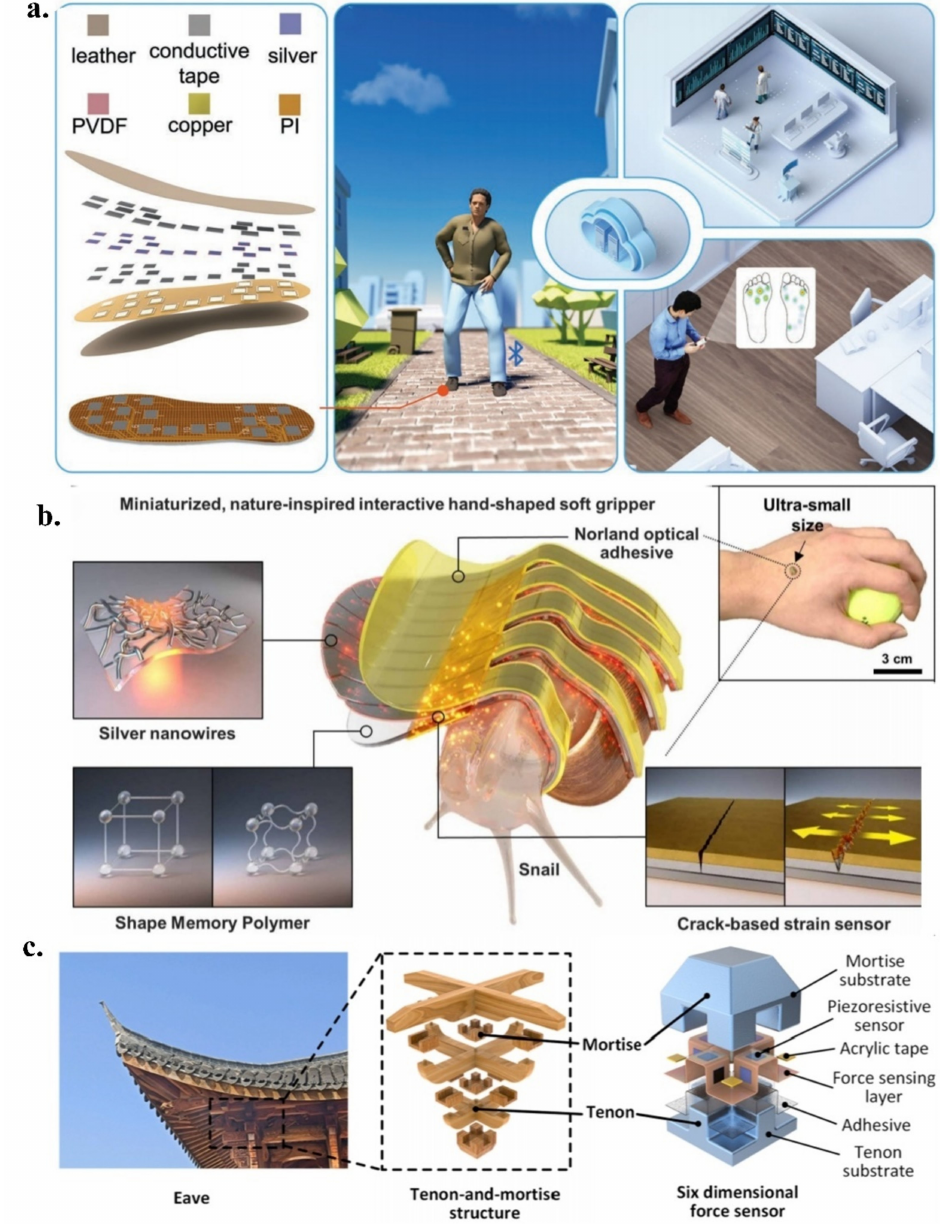
Figure 5. ( a ) Active sensing array; reproduced with permission from Wiley (2022) [109]; ( b ) Flexible gripper; reproduced with permission from the American Association for the Advancement of Science (2021) [111]; ( c ) Six-dimensional force sensor with a flexible mortise and tenon interlock structure; reproduced with permission from Elsevier (2022)